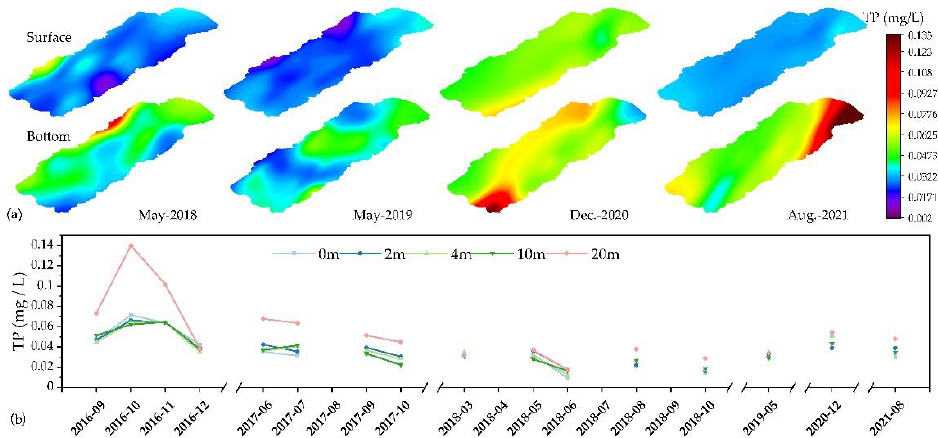
Figure 10. Changes in TP content in Lake Yangzong from 2017 to 2021. ( a ) indicates the distribution of TP content in the whole lake at the surface and bottom. ( b ) represents the mean value of TP content at 5 different depths.